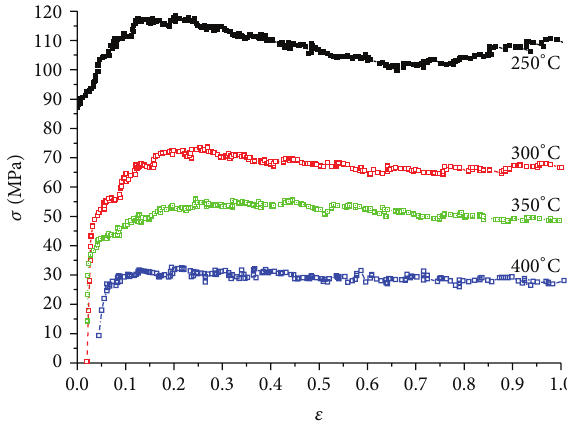
Figure 2: True stress/true strain curves obtained from the compres- siontestswithstrainrate0.1s −1 andthedifferentpresettemperatures 250 ∘ C, 300 ∘ C, 350 ∘ C, and 400 ∘